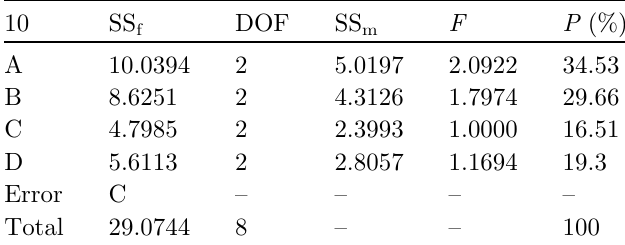
Table 6. Results of